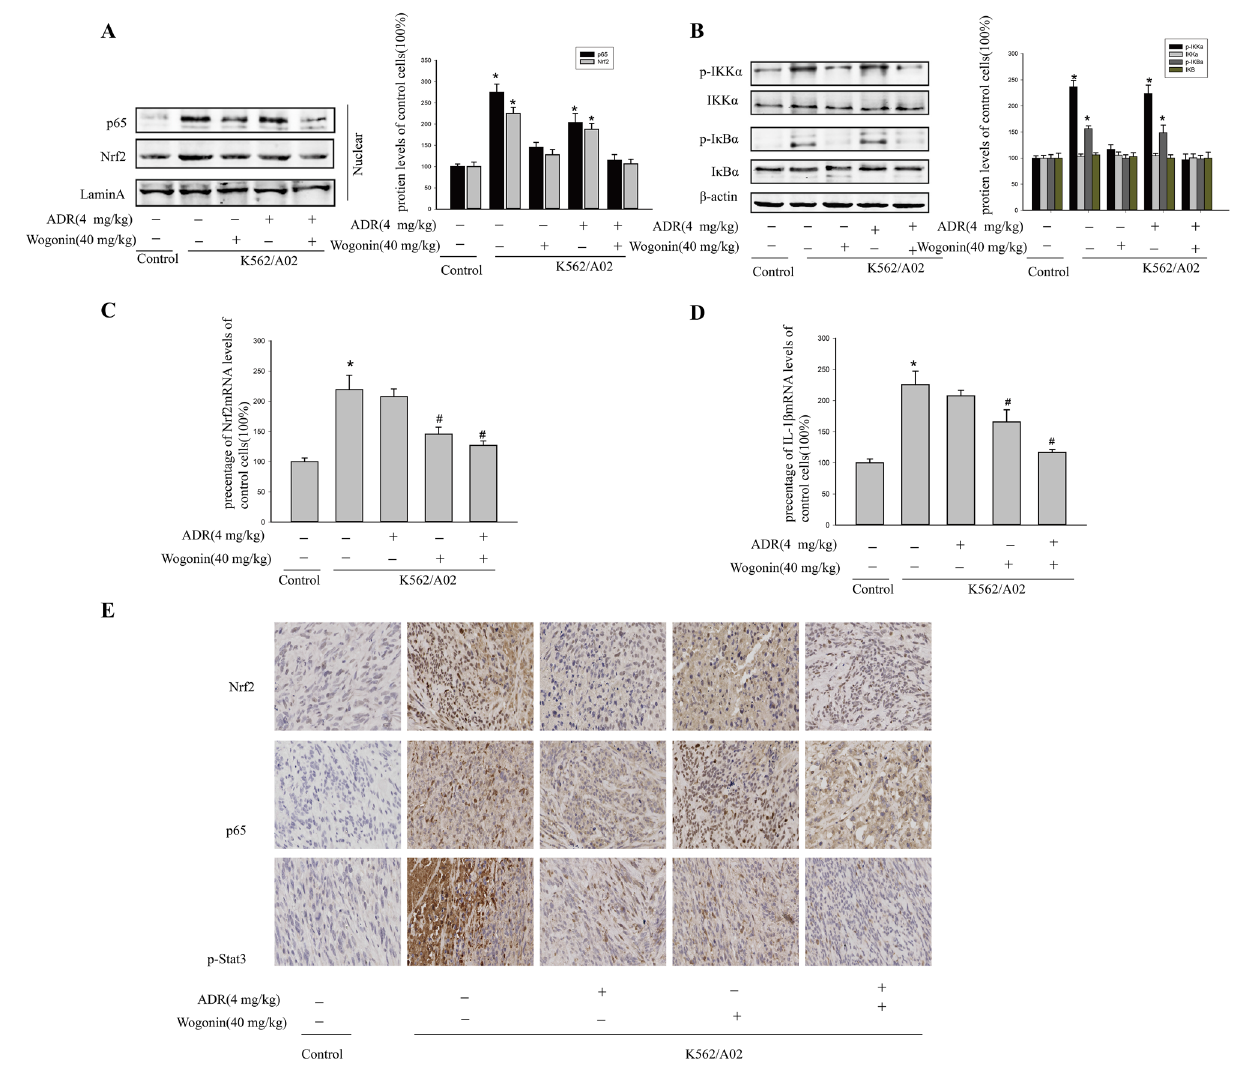
Figure 3. A correct version of original figure